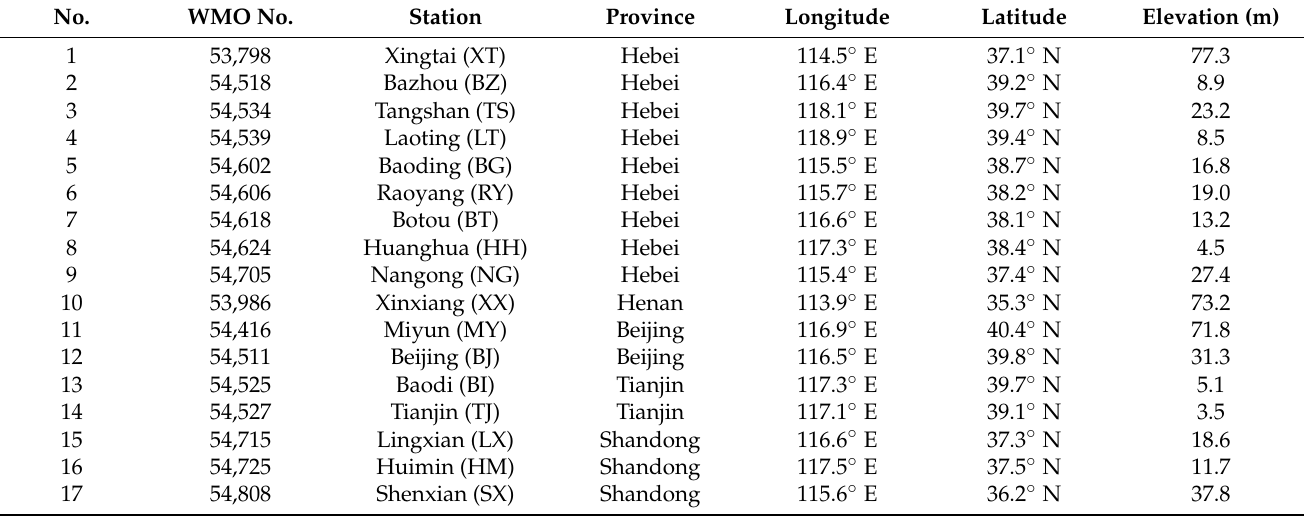
Table 1. Characteristics of weather stations in the study